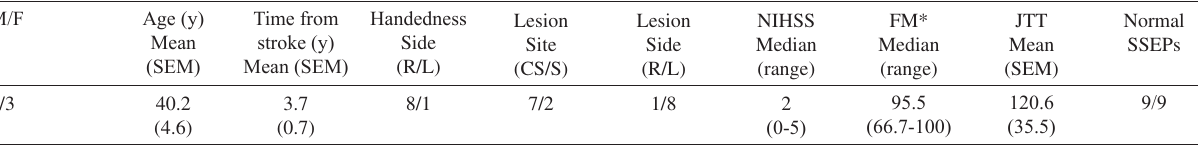
Table 1 - Patient characteristics. M, male; F, female; SEM, standard error of the mean; CS, cortico-subcortical involvement of corticomotor pathways; S, exclusive subcortical involvement of corticomotor pathways; R, right; L, left; y, years; NIHSS, NIH Stroke Scale; FM*, Fugl-Meyer Assessment, motor score (% of maximum score, paretic arm); JTT(s), Jebsen-Taylor test score (in seconds). SSEPs: somatosensory evoked potentials. Latencies and amplitudes of N9, N13, N20 and P14 were